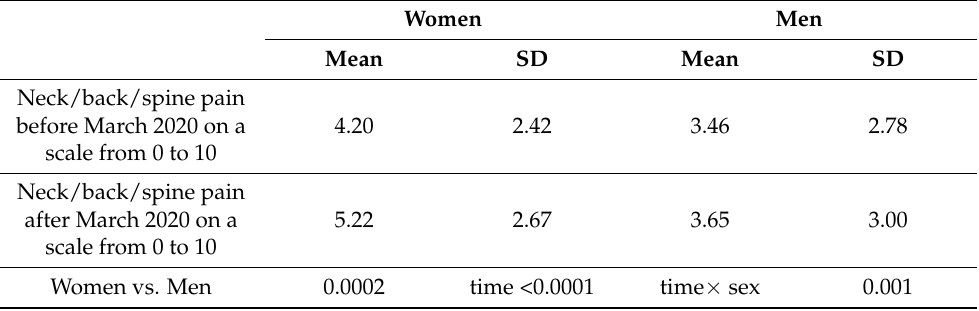
Table 5. Neck pain episodes before and during the pandemic.